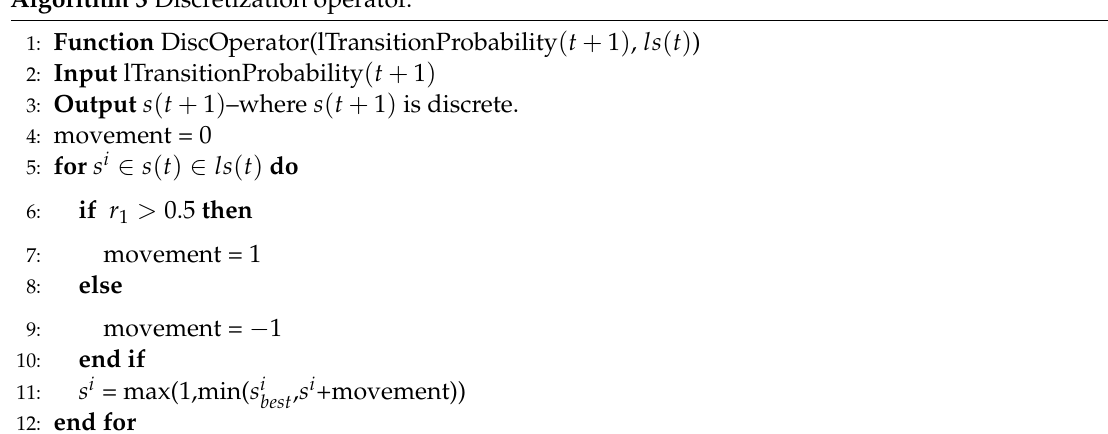
Algorithm 3 Discretization